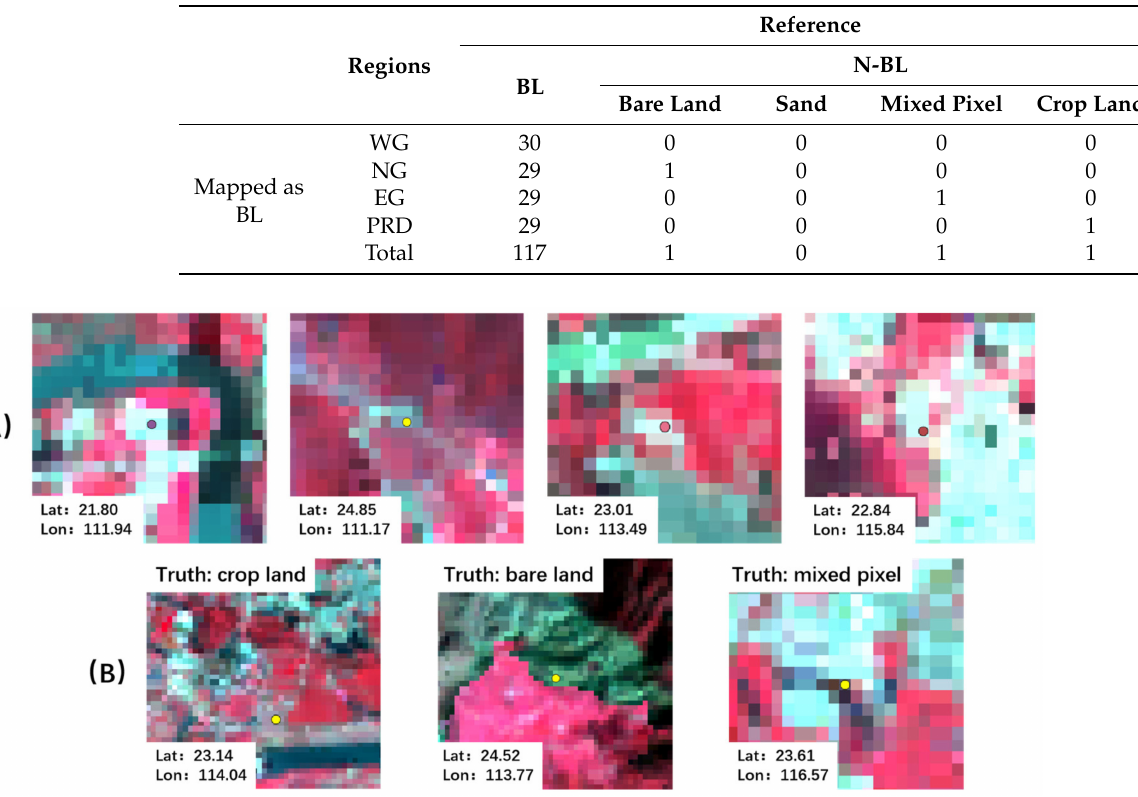
Figure 15. Examples of classification errors in the mapping of built-up land in Guangdong in 2020. ( A ) Examples of omission errors; ( B ) all commission errors in 120 built-up land validation